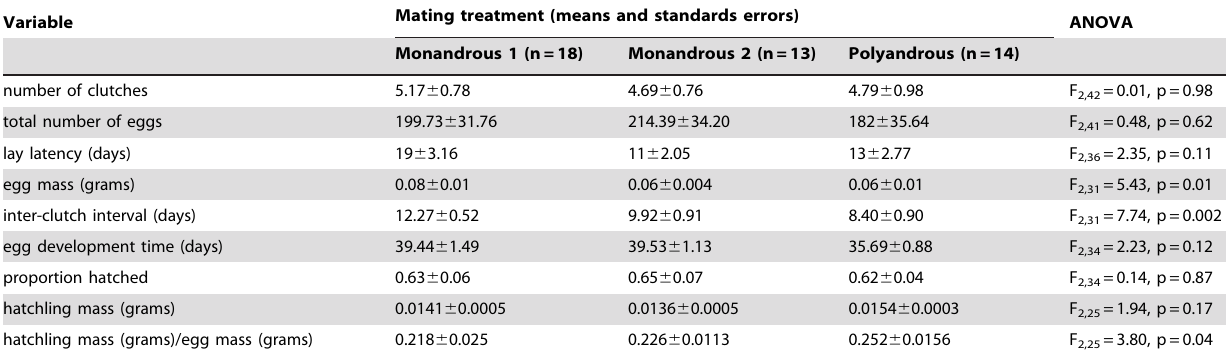
Table 1. Reproductive success of monandrous and polyandrous female E. tasmanica .